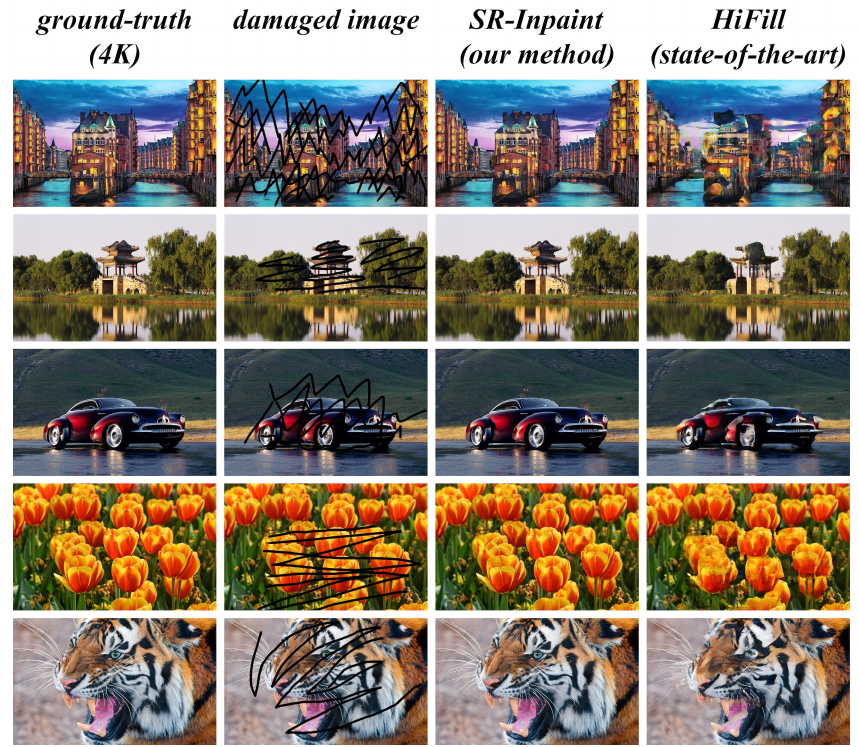
Figure 5. Example of inpainting results for 4K resolution: ( left to right ) ground-truth, input damaged image, inpainted image by our method, inpainted image by state-of-the-art